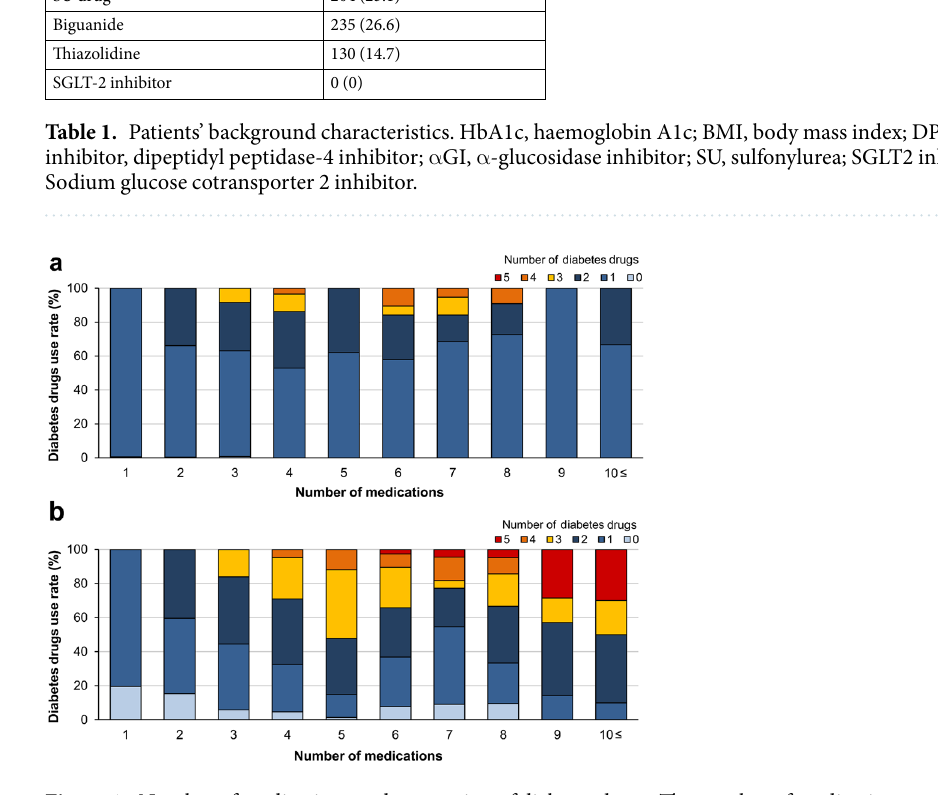
Figure 1. Number of medications and proportion of diabetes drugs. The number of medications and diabetes drugs at the start ( a ) and end ( b ) of the observation period are shown. At the start of the observation period, many diabetes drugs were used, whereas at the end of the observation period, the use of combination therapy showed an increasing